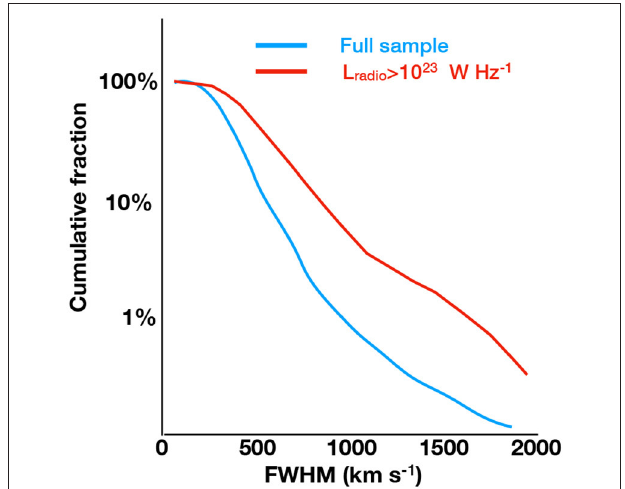
FIGURE 2 | Trend of the fraction FWHM of the [O III] λ 5007 lines for the AGN in Mullaney et al. (2013). The cyan line represents the entire sample while the red line illustrates that objects with FWHM > 1,000km s − 1 are ≈ 5 times more prevalent among AGNs with L > 1,023W Hz − 1 compared to the overall AGN population. The figure is based on data from Mullaney et al. (2013) and that no permission is required as the figure is